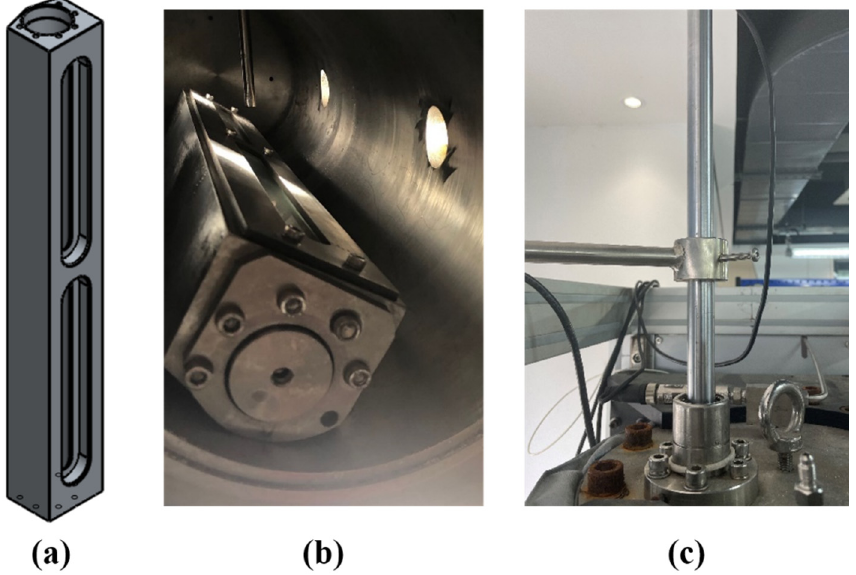
Figure 4. Structure of the built-in movable camera system. ( a ) Three-dimensional model drawing, ( b ) physical drawing, and ( c ) movable lever connected with the camera.